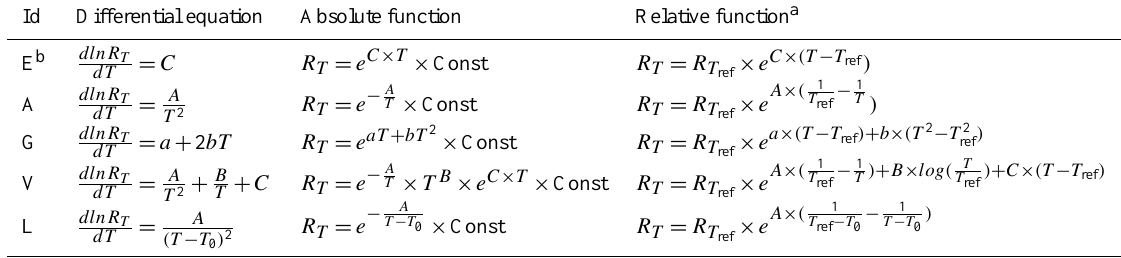
Table 1. Temperature response